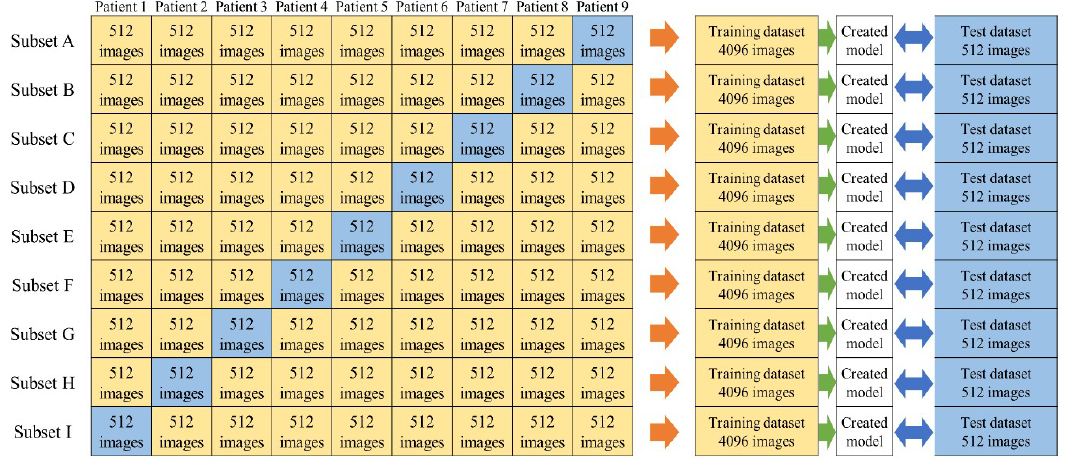
Figure 4. Nine video records divided into nine subsets to complete nested cross-validation.